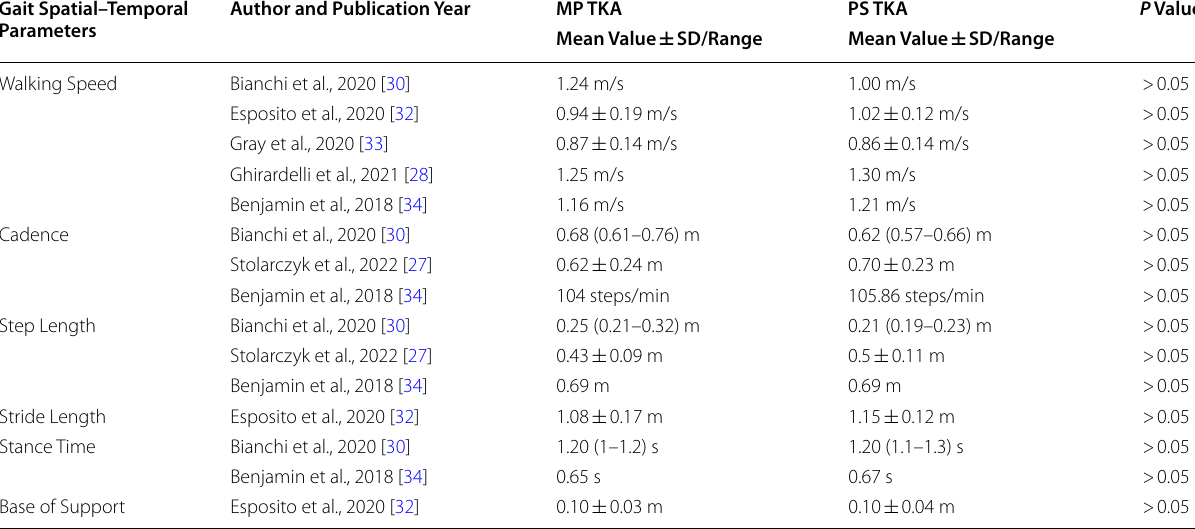
MP Medial pivot, PS Posterior stabilised, SD Standard deviation, m Metres, s Seconds, min